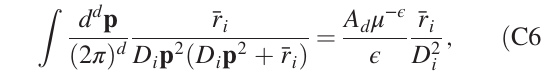
FIG. 10. One-loop corrections to (a,b) r 1 ϕ 1 ˜ ϕ σ u ϕ 2 ϕ 12 2 2 can be obtained by switching thin black and thick cyan 1 ¯ r − r , we can determine the Z factors for ¯ r ¼ r i i i c